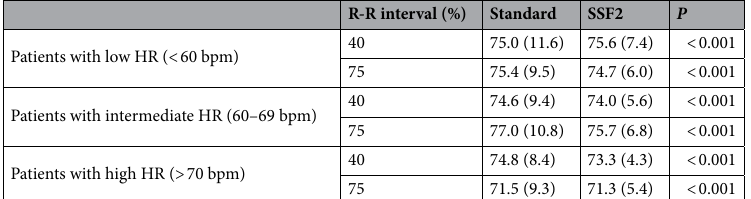
R-R interval (%) Standard SSF2 P Patients with low HR (< 60 bpm)